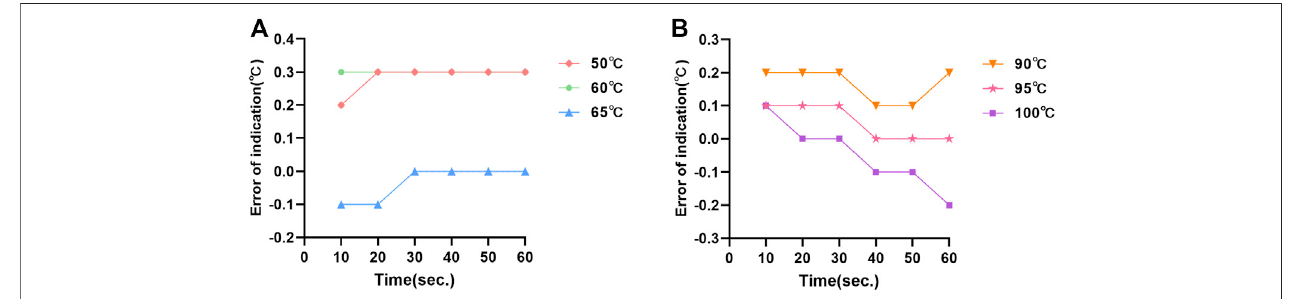
FIGURE3| Theerrorsofindicationoftemperaturemeasurementatthecentralpointofdualtemperaturemodules: (A) theerrorsofindicationofthe “ A ” module; (B) the errors of indication of the “ B ” module.